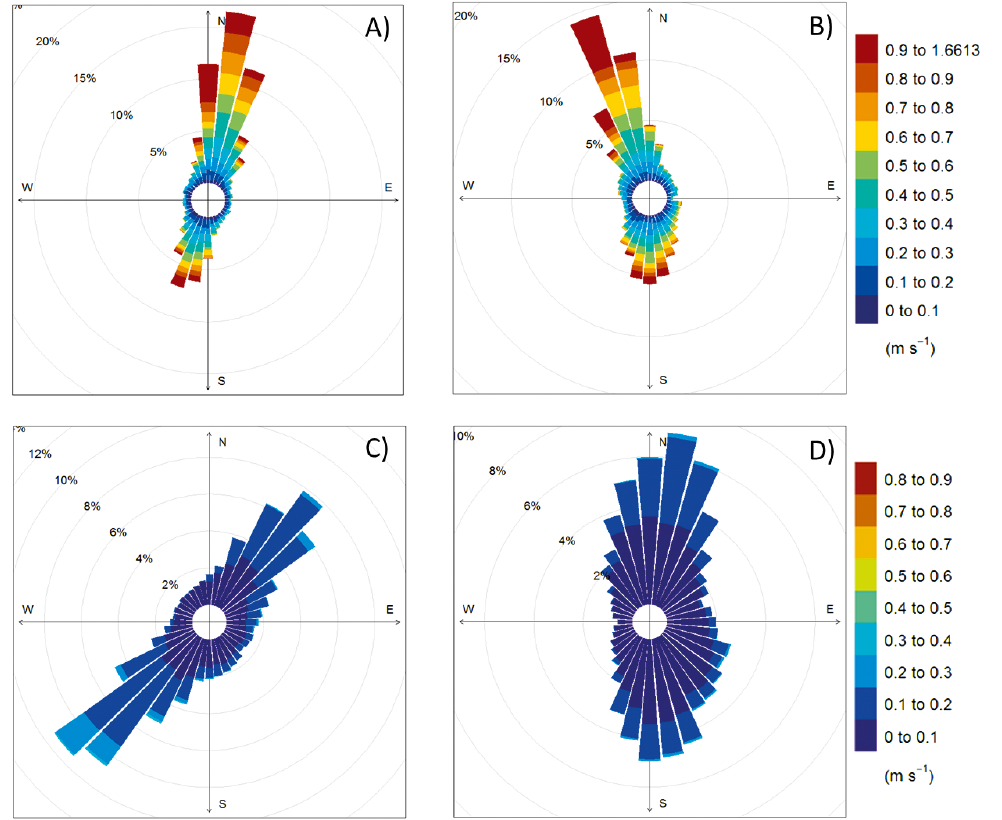
Fig. 4. Annual average (2009) of (A,B) surface and (C,D) bottom ve- locity direction and magnitude of